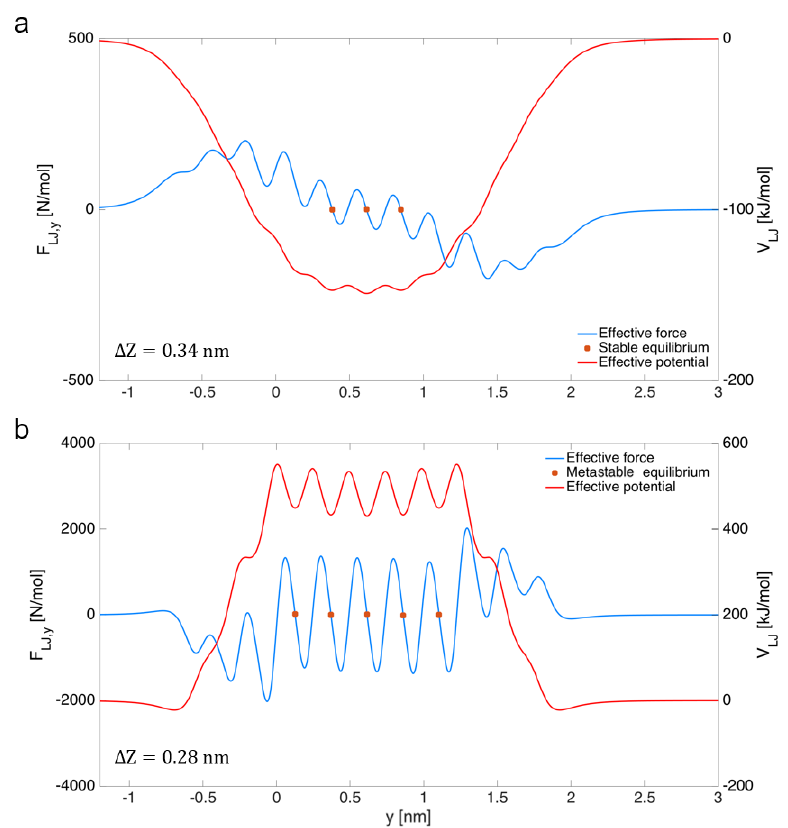
Figure 5. VdW potential (red lines) and effective force (blue lines) exerted by the stationary graphene sheet on the sliding one along the y direction. The two sheets are either ( a ) ∆ Z = 0.34 nm or ( b ) ∆ Z = 0.28 nm apart from each other. Orange dots correspond to either stable or metastable equilibrium positions,